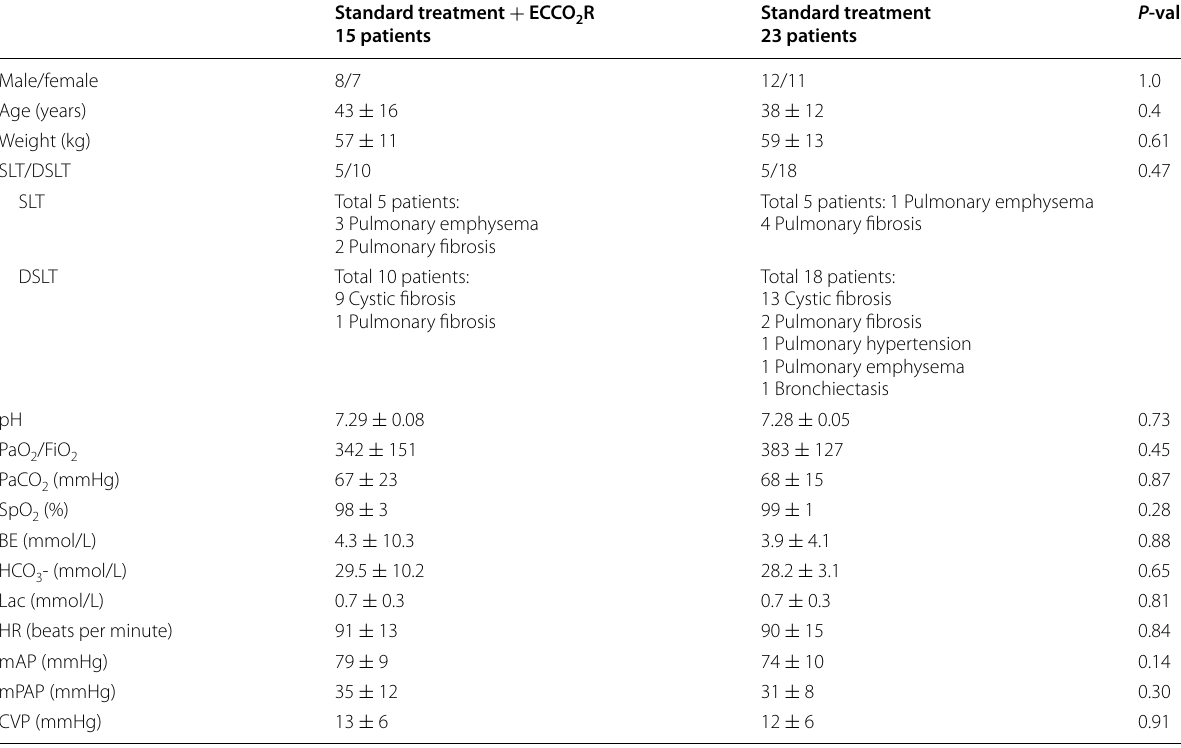
Values are expressed as mean